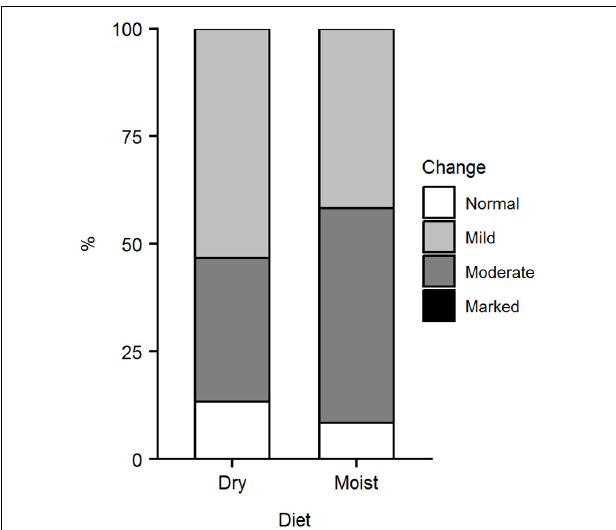
FIGURE 3 | Histological evaluation of liver in ballan wrasse fed either dry or moist diets. The graph shows the percentage of hepatocytes with either marked, moderate, mild or normal levels of vacuolization in the liver. Data were from 15 (dry diet) or 12 (moist diet) fish. There was no statistical difference between moist and dry diets (Fisher’s Exact test, p >